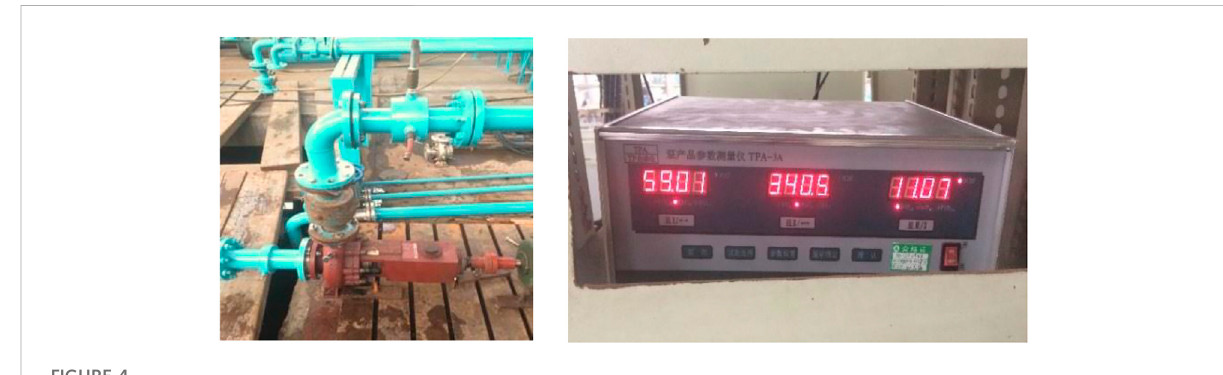
FIGURE 4 Real scenery of the performance test.